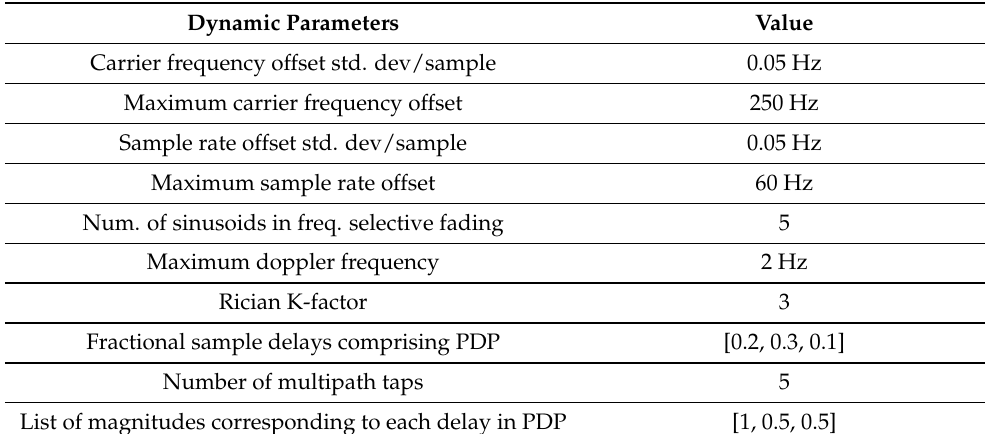
Table 1. RadComDynamic: Dynamic settings. Dynamic Parameters Value Carrier frequency offset std. dev/sample 0.05 Hz Maximum carrier frequency offset 250 Hz Sample rate offset std. dev/sample 0.05 Hz Maximum sample rate offset 60 Hz Num. of sinusoids in freq. selective fading 5 Maximum doppler frequency 2 Hz Rician K-factor 3 Fractional sample delays comprising PDP [0.2, 0.3, 0.1] Number of multipath taps 5 List of magnitudes corresponding to each delay in PDP [1, 0.5,